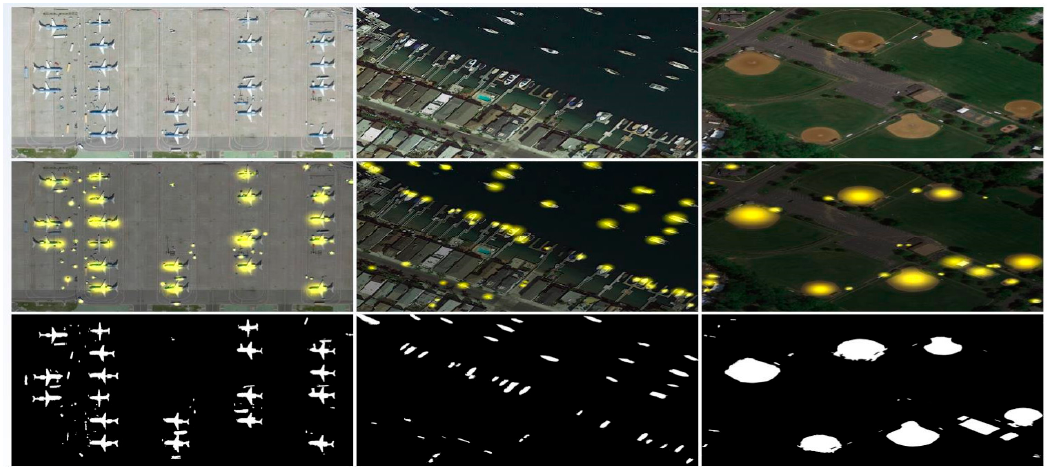
Figure 6. Qualitative results of SOSA-FCN. The first row shows the original images, the second row shows the fixation maps of the object, and the third row shows the attention feature maps of the object.